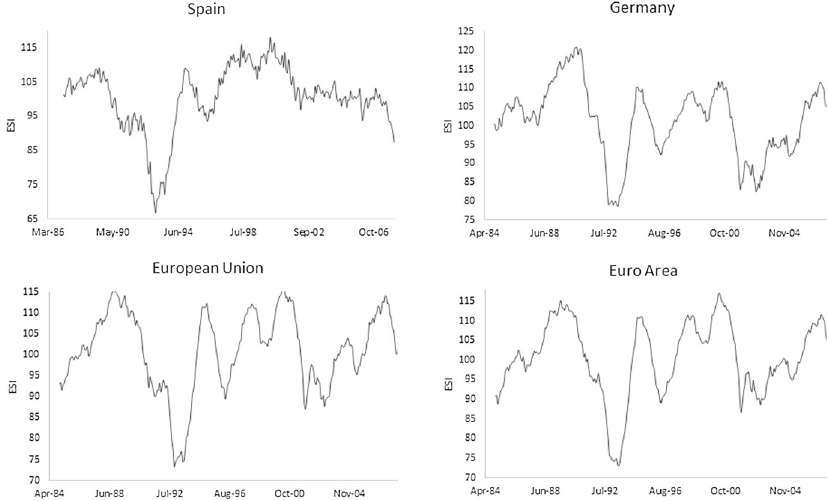
Fig. 1 ESI series. Source: author’s calculations